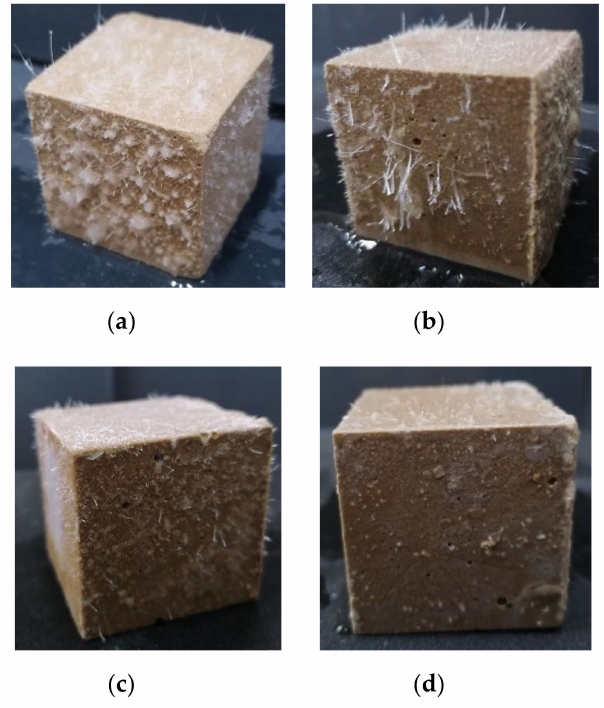
Figure 4. The surface state of MPC specimens prepared with early strength agents after soaking in water: ( a ) (CH 2 OH) 2 ; ( b ) HCOOK; ( c ) KCl; and ( d ) H 3 PO 4